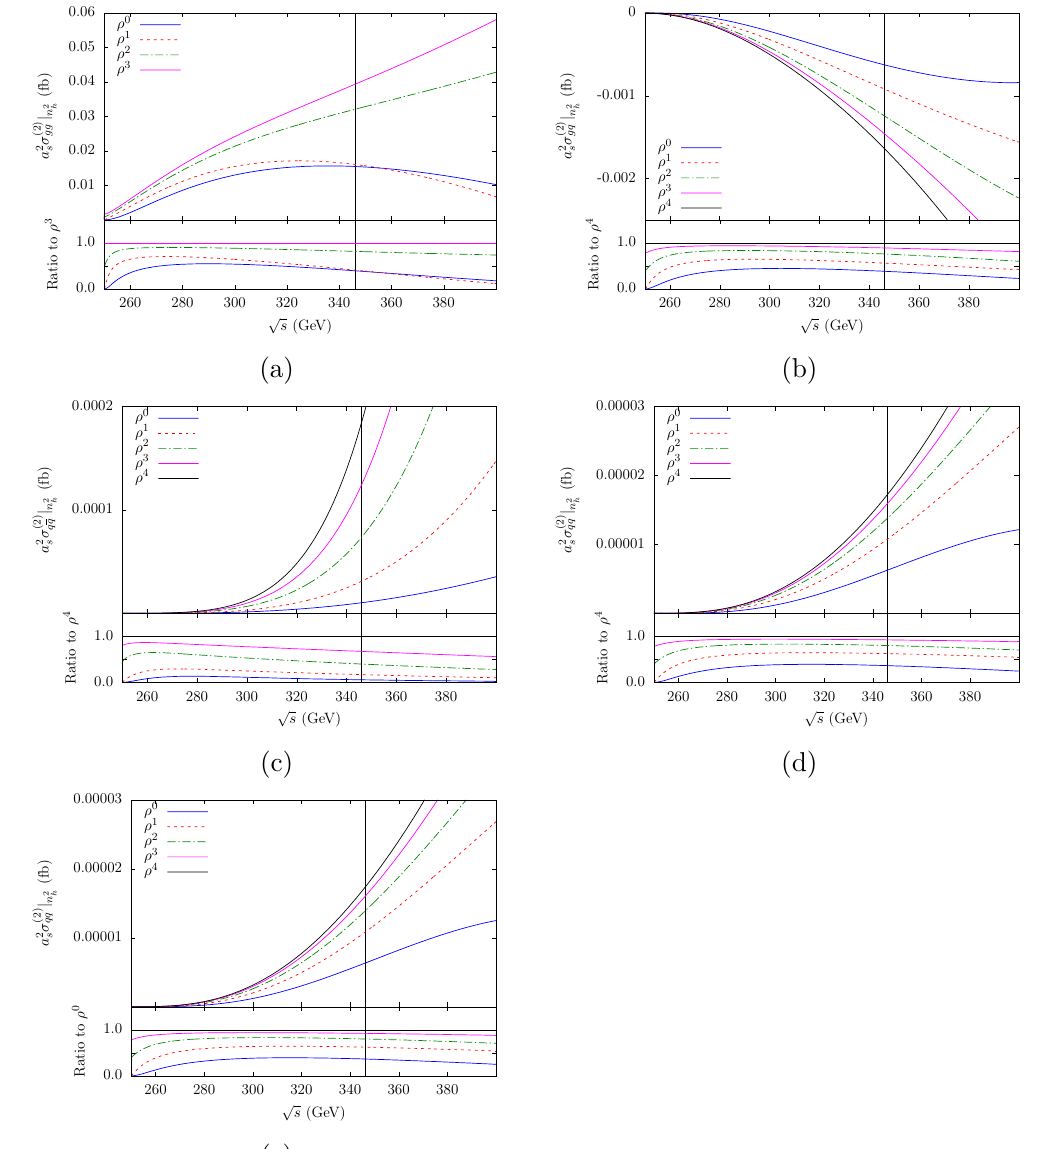
√ s , with the renormalization /m 2 t H = α (5) . The s /π s √ s = 2 m t . In the lower part of the plots the